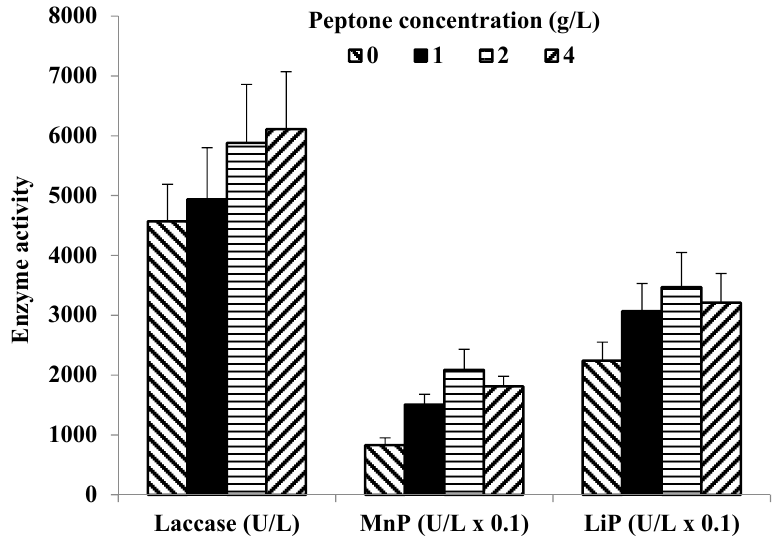
Figure 3. The effect of peptone concentration on the C. gallica 142 LME activities. The nutrient medium containing 10 g/L glycerol and 40 g/L mandarin peels; peptone concentration varied from 0 to 4 g/L.